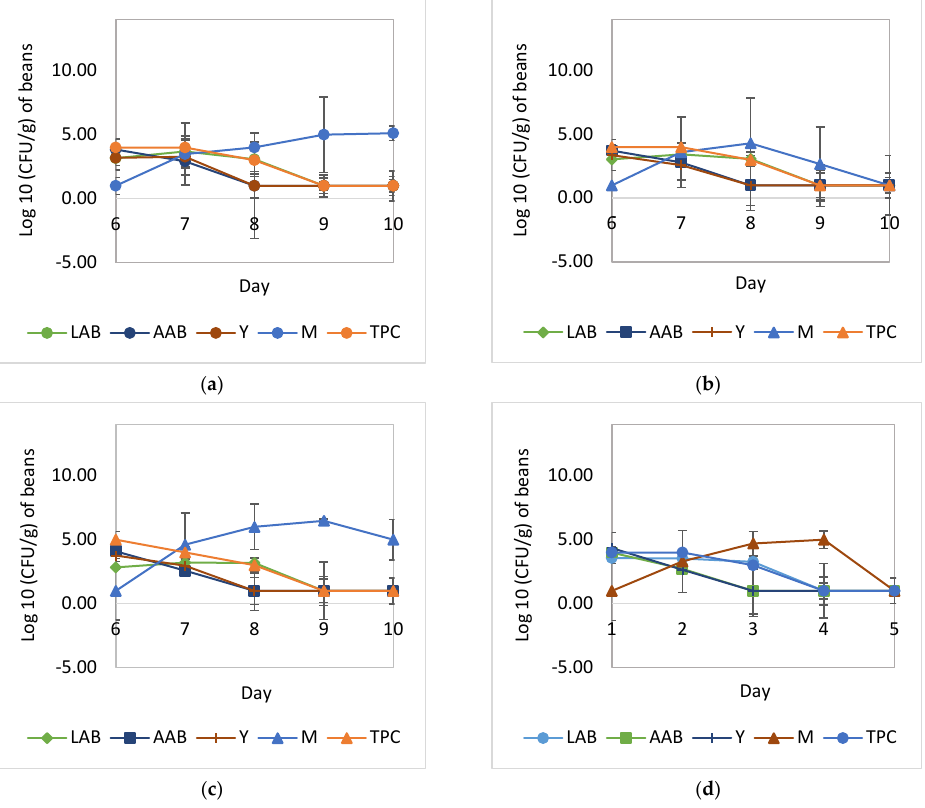
Figure 5. Growth of yeast, LAB, AAB, and mold during the course of drying: ( a ) natural fermentation; ( b ) fermentation with the addition of L. plantarum HL-15 and A. niger YAC-9; ( c ) natural fermentation with the addition of A. niger YAC-9; ( d ) fermentation with the addition of L. plantarum HL-15, C. famata HY-37, Acetobacter spp. HA-37, and Aspergillus niger YAC-9. LAB, total lactic acid bacteria; AAB, total acetic acid bacteria; Y, total yeast; M, total mold; TPC, total plate count.